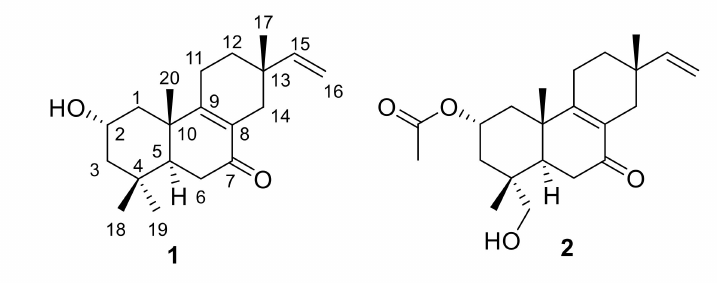
Figure 1. Chemical structures of compounds 1 and 2